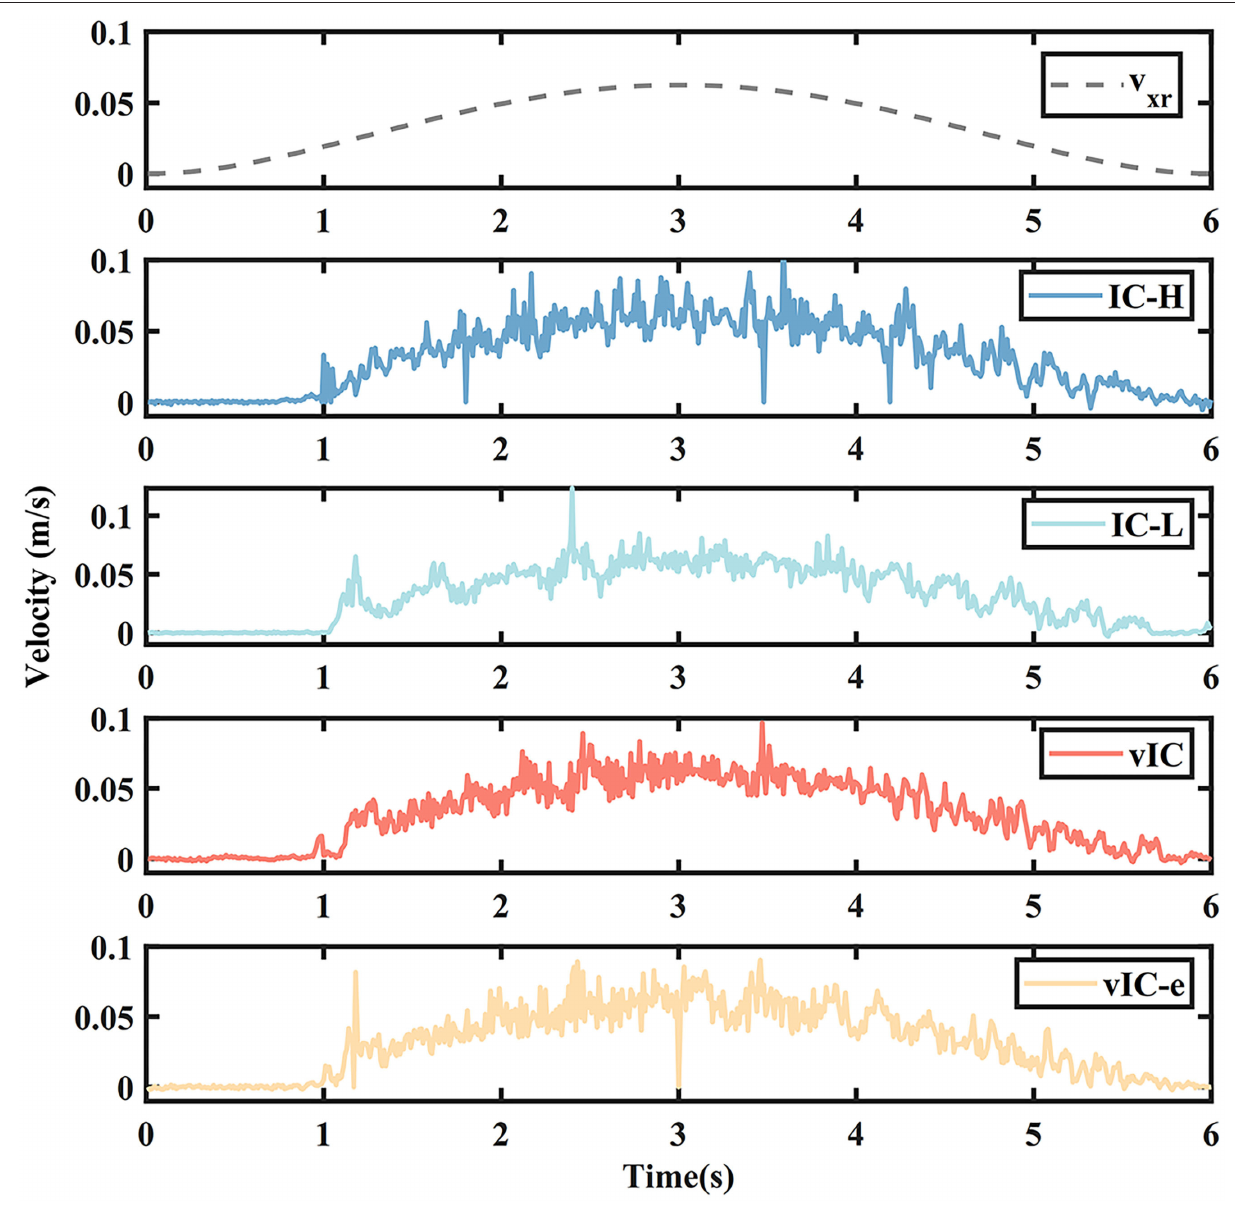
FIGURE 7 | The actual (solid lines) and desired (gray dashed line) velocity profile of four control algorithms during a rightward